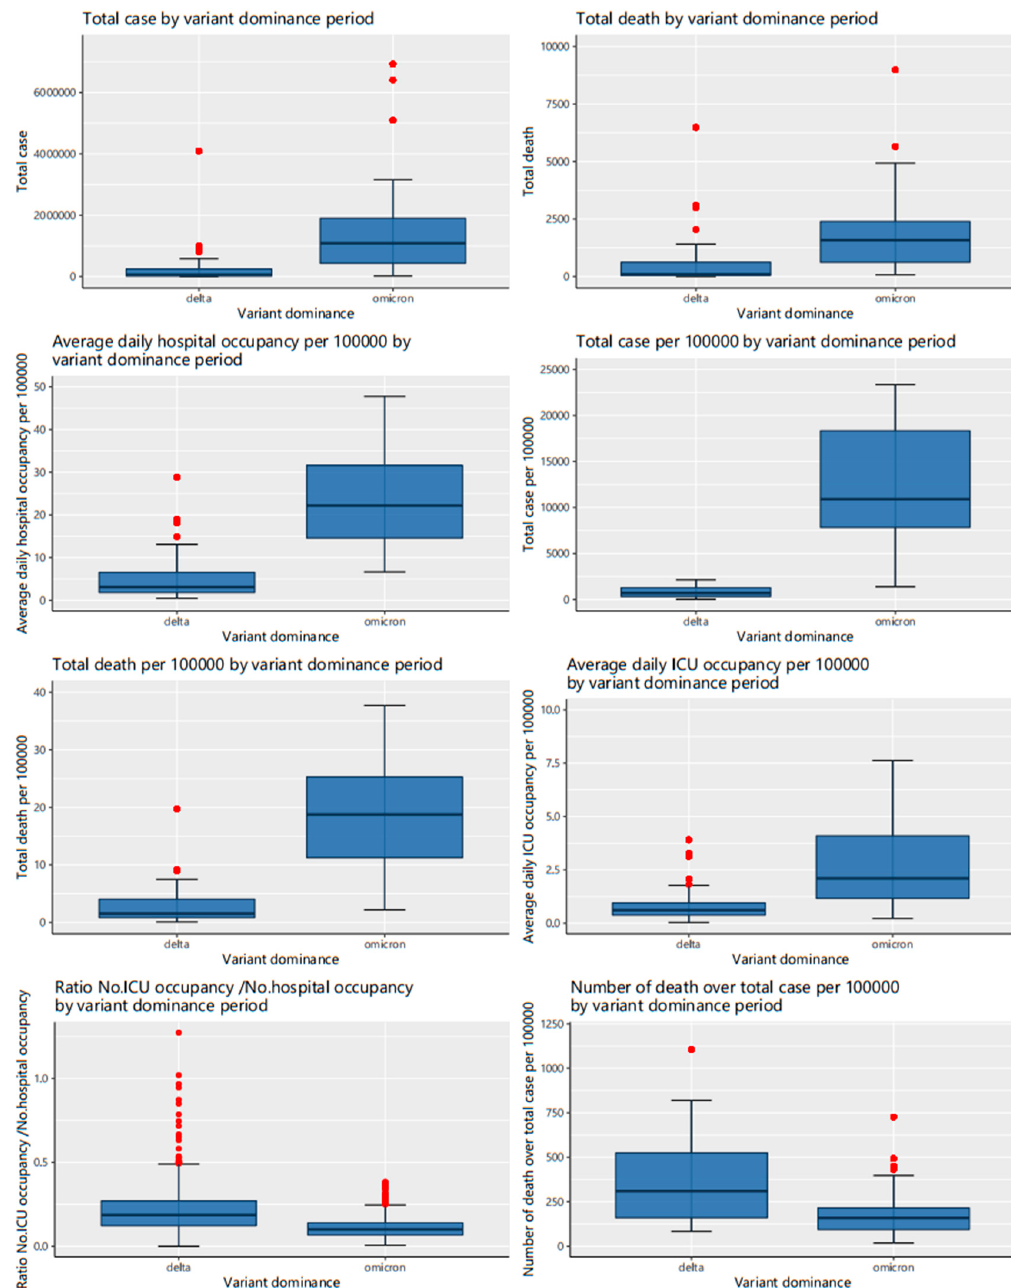
Figure 3. COVID-19 infection characteristics between the Delta and Omicron variant periods.